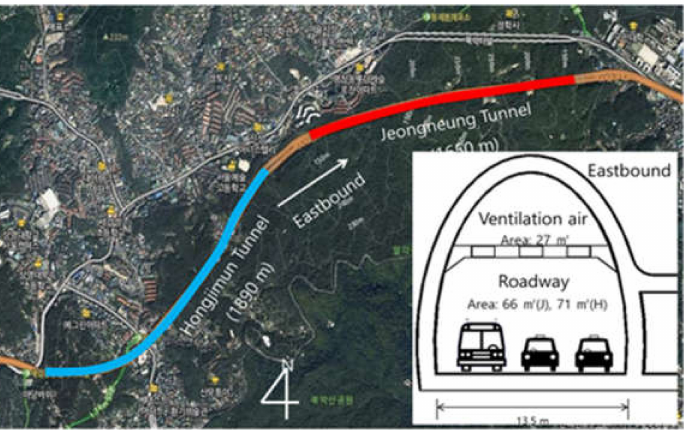
Figure 2. Monitoring area of the roadway tunnels in this study (Adapted from Park et al. [26]).